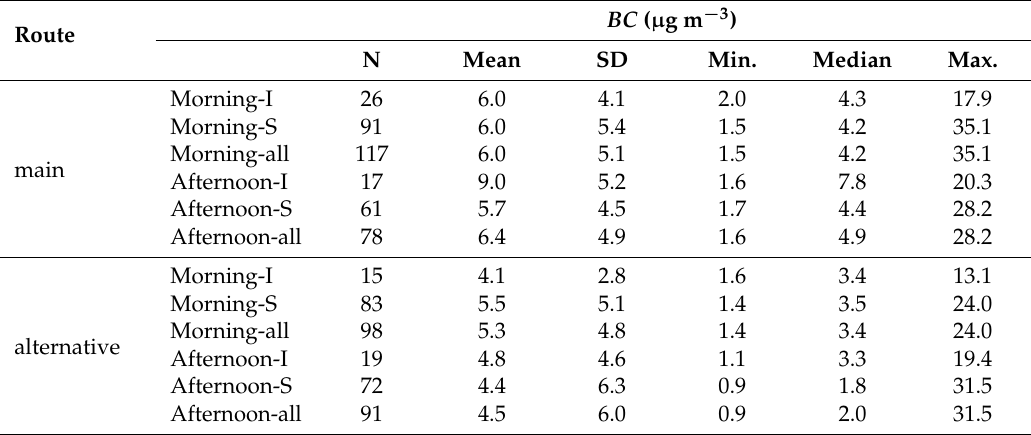
Figure 7. Mobile measurements of BC concentration following the main and alternative cycling route (Figure 1) during the morning traffic rush hour ( a ) and in the afternoon ( b ). BC concentration is presented in color scale (logarithmic). Table 2. Summary statistics of mobile BC measurements along the main and alternative route. Measurements are grouped to intersection segment (I) and straight segment (S) of the route (N—number of data points, SD—standard